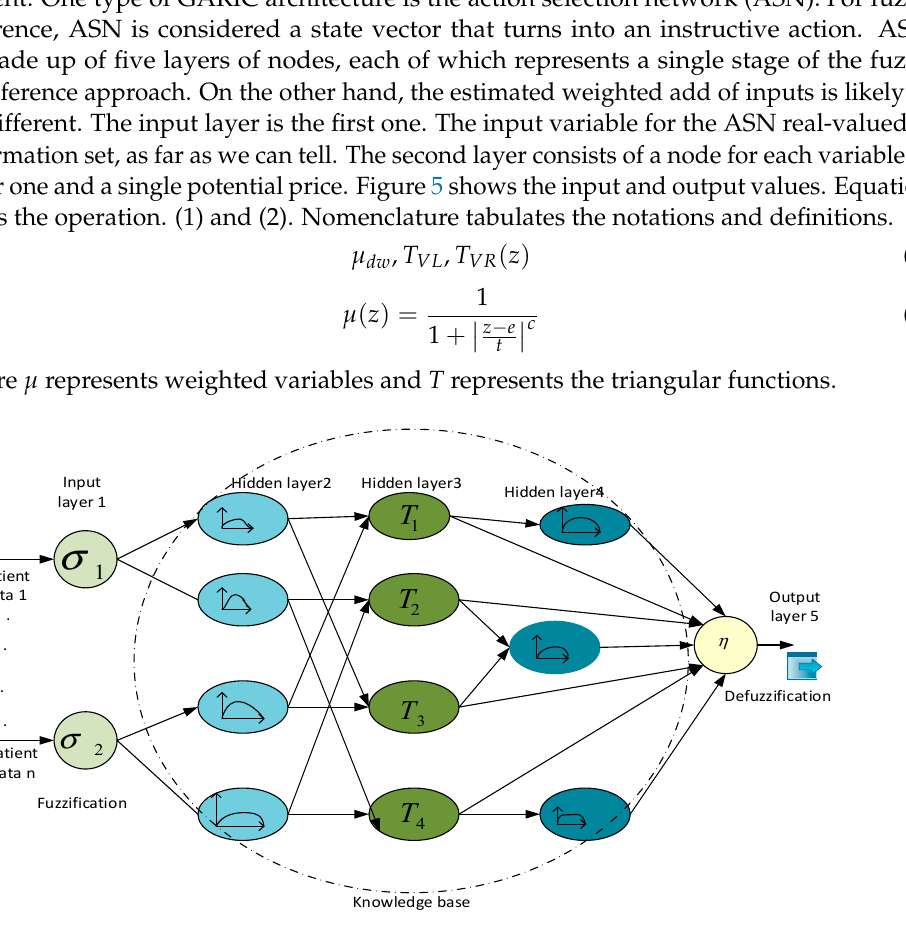
Figure 5. Action selection network with its activation